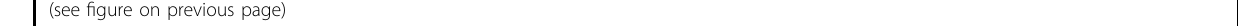
Fig. 2 Knockdown of PER1 promoted glycolysis and proliferation in OSCC cells, while overexpression of PER1 inhibited glycolysis and proliferation in OSCC cells. A Western blot results showed that the expression levels of HK2, PKM2, and LDHA were signi fi cantly increased in RNAi- PER1-TSCCA cells and decreased in OE-PER1-SCC15 and OE-PER1-CAL27 cells. B – D The results of the glucose uptake, lactate production, and enzyme activity assays showed that glucose uptake, lactate production, and the enzymatic activity of HK, PK, and LDH were signi fi cantly increased in RNAi- PER1-TSCCA cells, while in OE-PER1-SCC15 and OE-PER1-CAL27 cells, glucose uptake, lactate production, and the enzymatic activity of HK, PK, and LDH were signi fi cantly decreased. E , F CCK-8 and MTT assays showed that the proliferation of RNAi-PER1-TSCCA cells was signi fi cantly increased, while that of OE-PER1-SCC15 and OE-PER1-CAL27 cells was signi fi cantly decreased. All data are from three independent experiments. The data are presented as the mean ± SD values ( n ≥ 3). * P < 0.05; ** P < 0.01; *** P < 0.001; **** P <